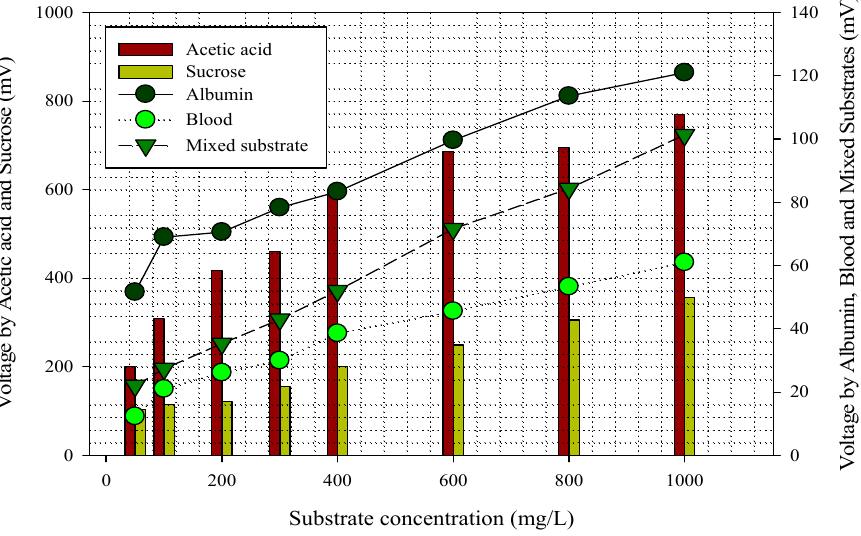
Figure 7. Voltage generated by various substrates after each batch experiment.